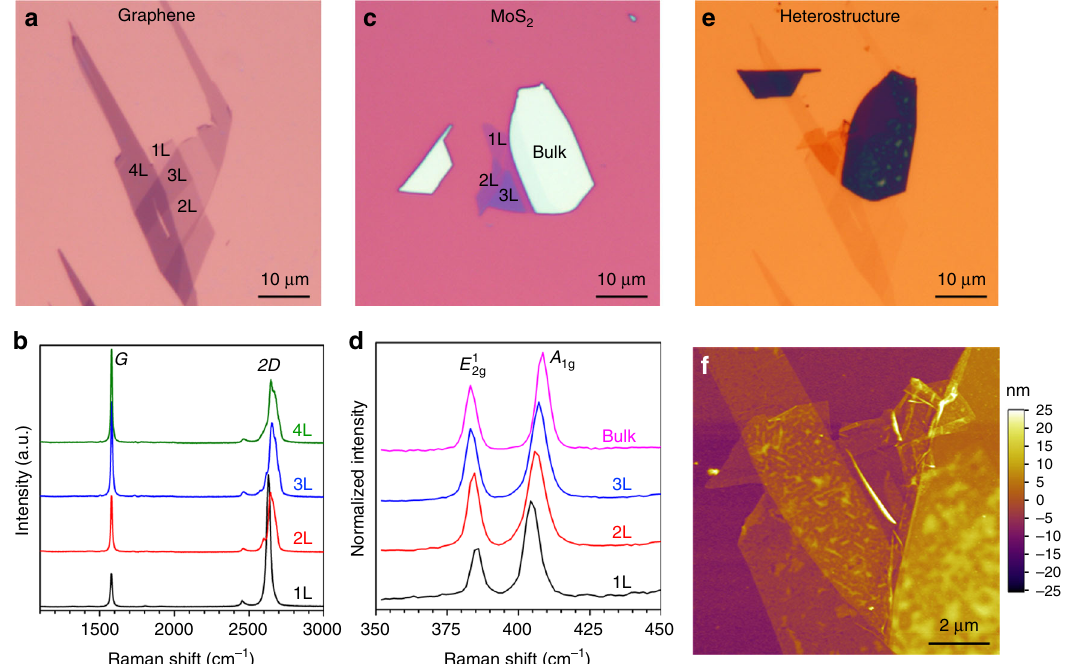
Fig. 1 Sample fabrication and optical characterization. a Optical microscopy photo of the mechanically exfoliated graphene of different thicknesses on 90 nm SiO 2 /Si; ( b ) the corresponding Raman spectra (514.5 nm wavelength); ( c ) optical microscopy photo of the as-exfoliated MoS 2 on 270 nm SiO 2 /Si; ( d ) the corresponding Raman spectra; ( e ) optical microscopy photo of the MoS 2 (top)/graphene (bottom) heterostructures transferred onto 100 nm-thick Au coated SiO 2 /Si by PMMA method; ( f ) the corresponding AFM image of the